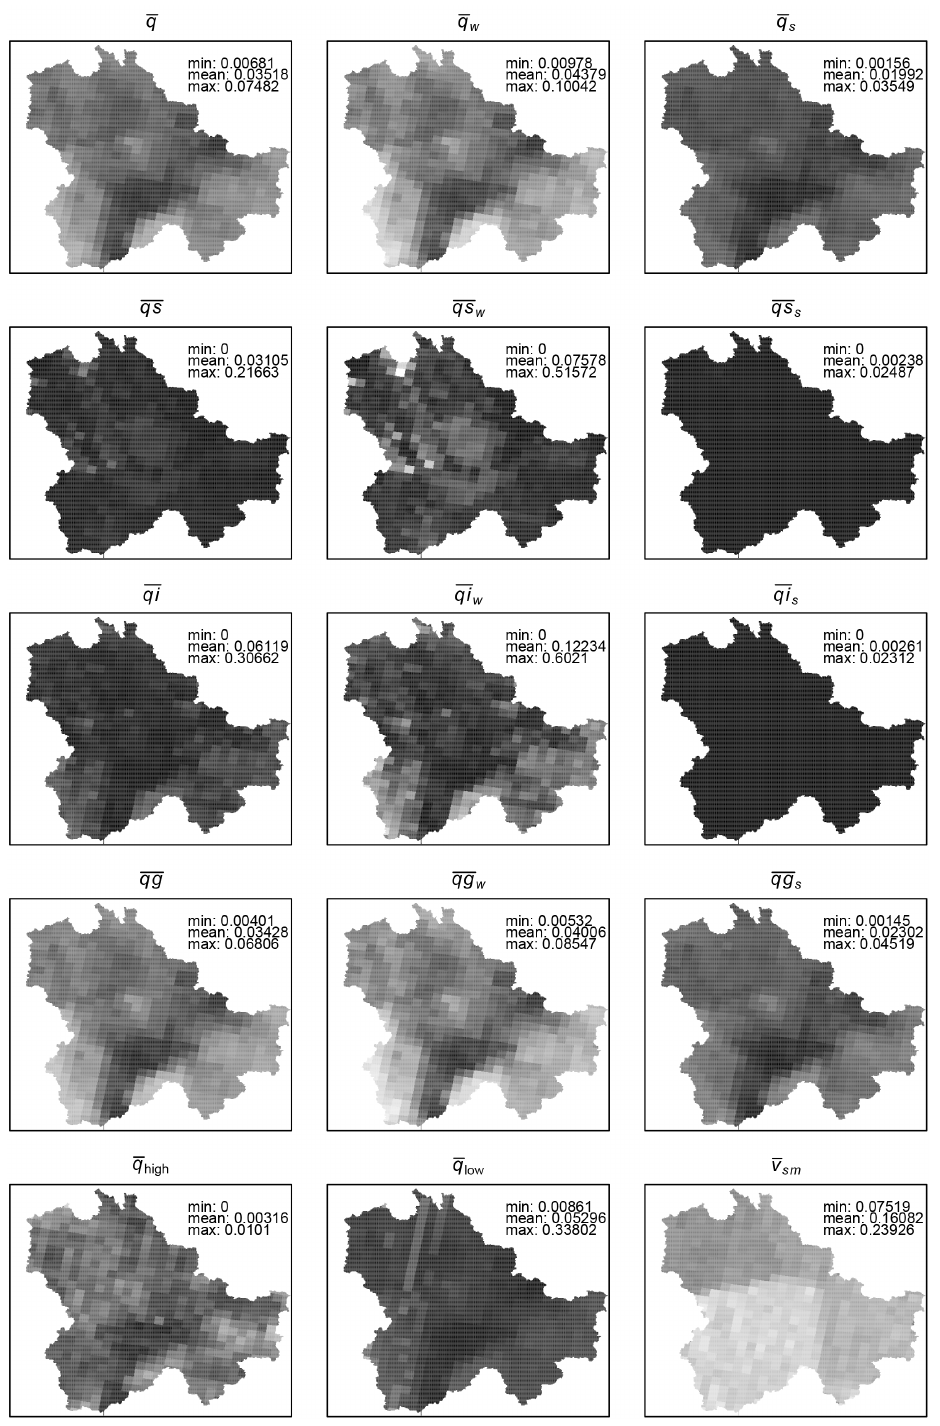
Figure 8. The SCF sensitivity maps showing (cid:63) s i in snow zones of the WetSpa model for Biebrza River catchment for different response functions. The grey scale represents linearly stretched (cid:63) s i values between minimum (black) and maximum (white); for the top four rows the grey scale is selected to match the data range of all maps in each row; in the lowest row each map has individual grey scale between the minimum and maximum values indicated on the plots (see Sect. 3.2 for details). Explanation of the response functions is presented in Table